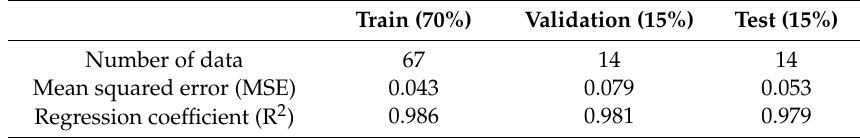
Table 3. The performance of the neural network in predicting the efficiency.